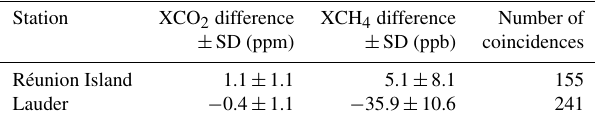
Table 2. This table presents the results of the comparison be- tween the COCCON station in Gobabeb and the TCCON stations in Lauder and Réunion Island. Difference and SD are given as the mean difference and 1 standard deviation between the coincident daily TCCON and COCCON XCO 2 and XCH 4